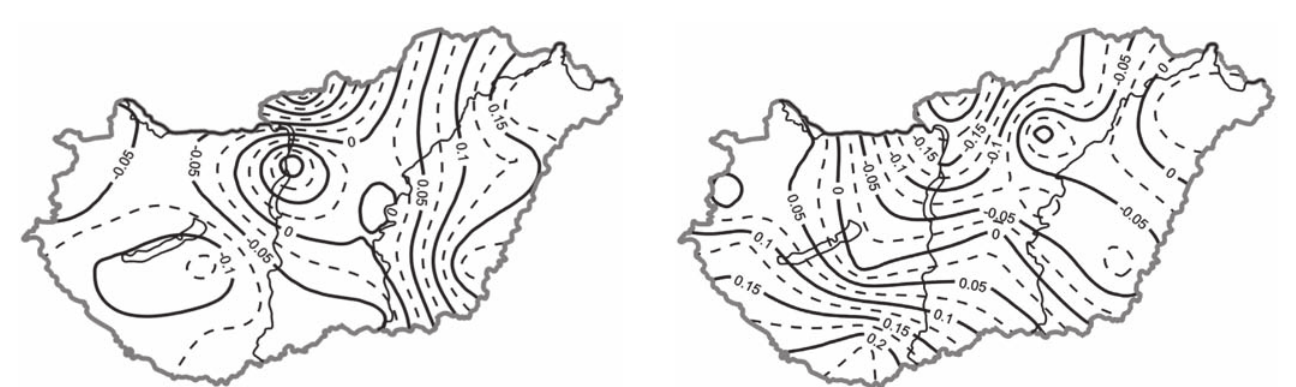
Figure 10 – The mean monthly slope values of the trend-function expressing the changes of the absolute maxima of precipitation according to data raised at 16 stations over 1951–2010